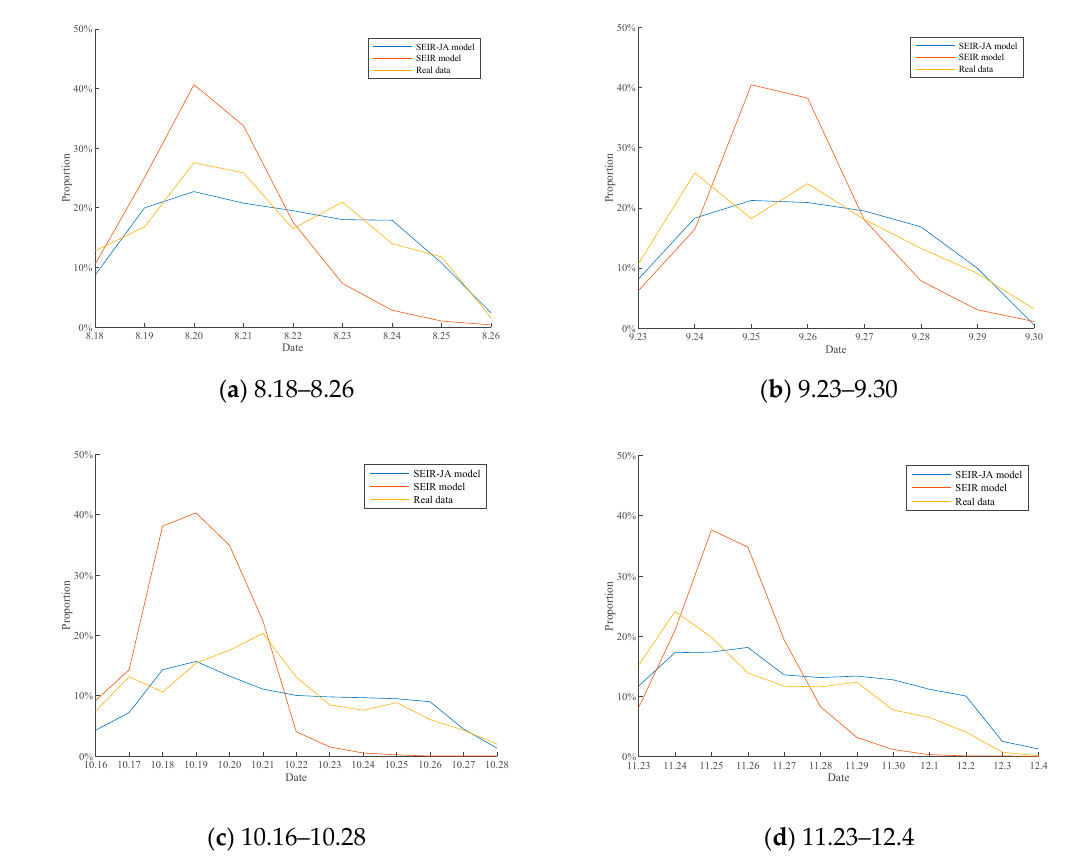
Figure 16. The ratio of the number of comments.